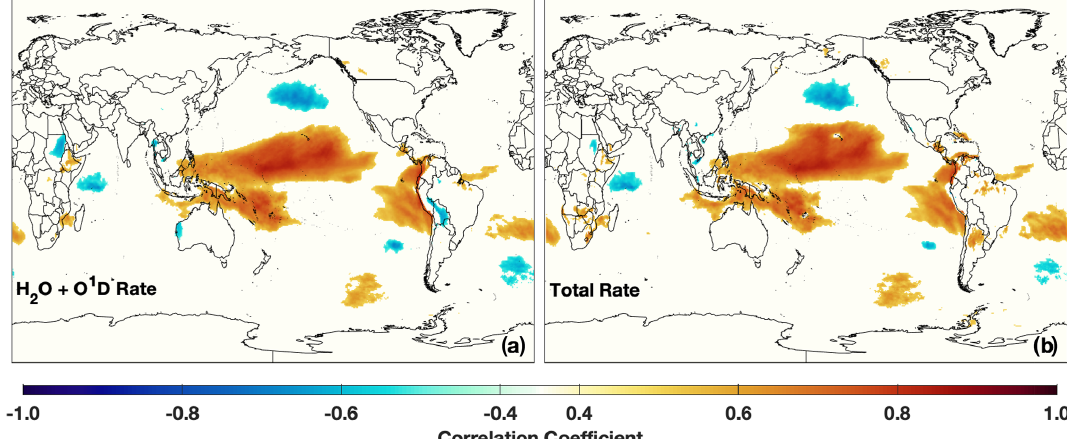
Figure 12. Correlations of the MEI with the production rate of OH from the H 2 O + O 1 D reaction (a) for DJF and the total OH production rate, as defined in the text, (b) for the PBL level are shown.